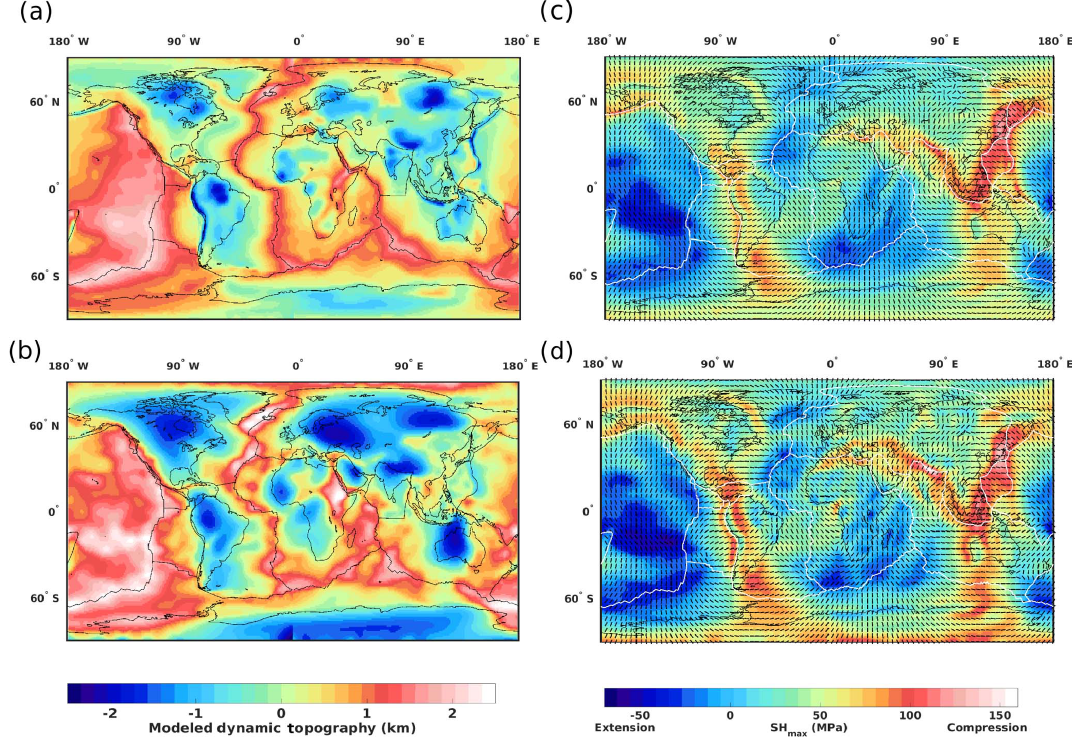
Figure 8. Modeled “dynamic” topography using the upper mantle structure (a) TM1 and (b) TM2 and corresponding SH max prediction with (c) TM1 and (d) TM2. In contrast to Fig. 4, the effect of the crust is not included